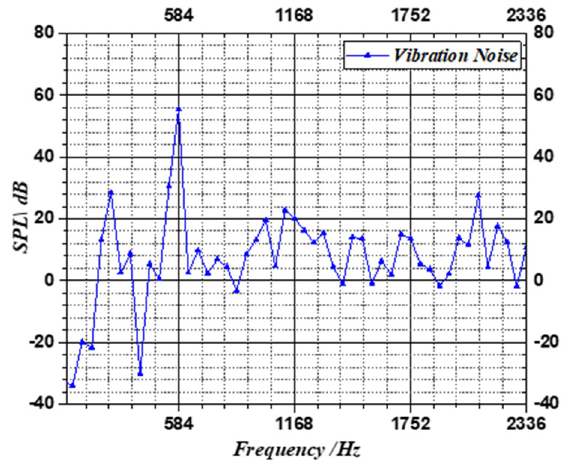
Figure 16. The spectrum chart of vibrational sound radiation of the volute casing (numerical).